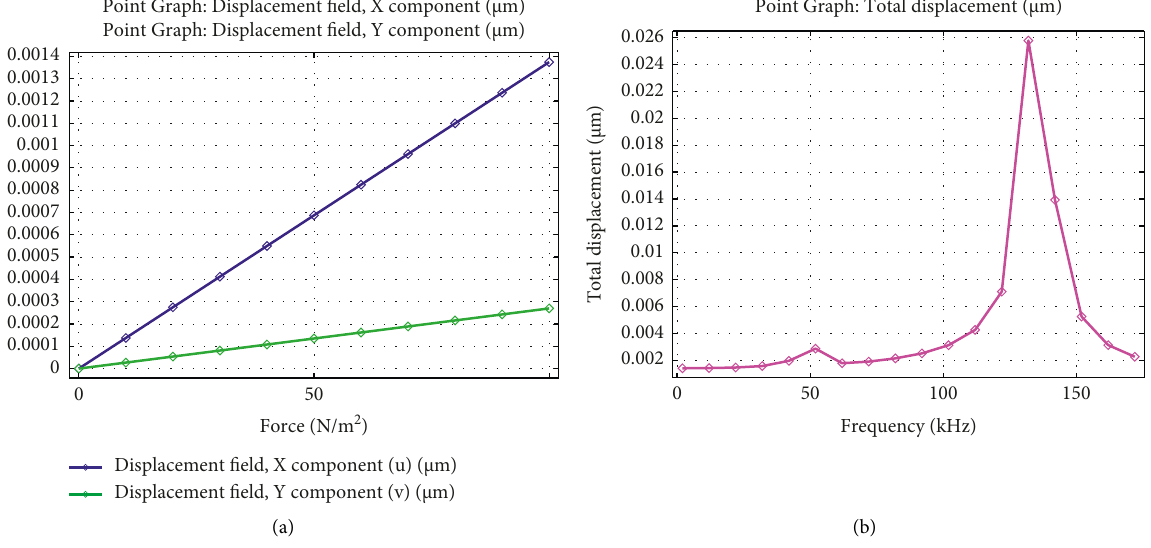
Figure 8: (a) Displacement characteristics; (b) natural frequency for the proposed sensor